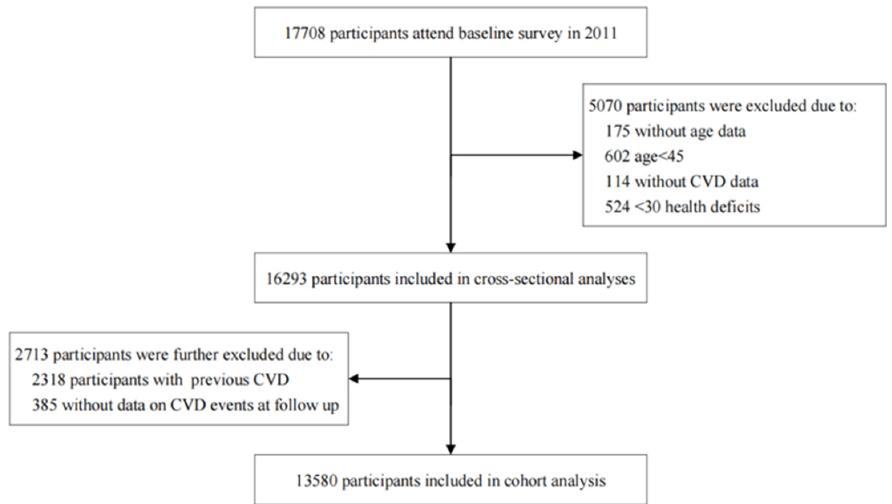
Figure 1. Flowchart of study